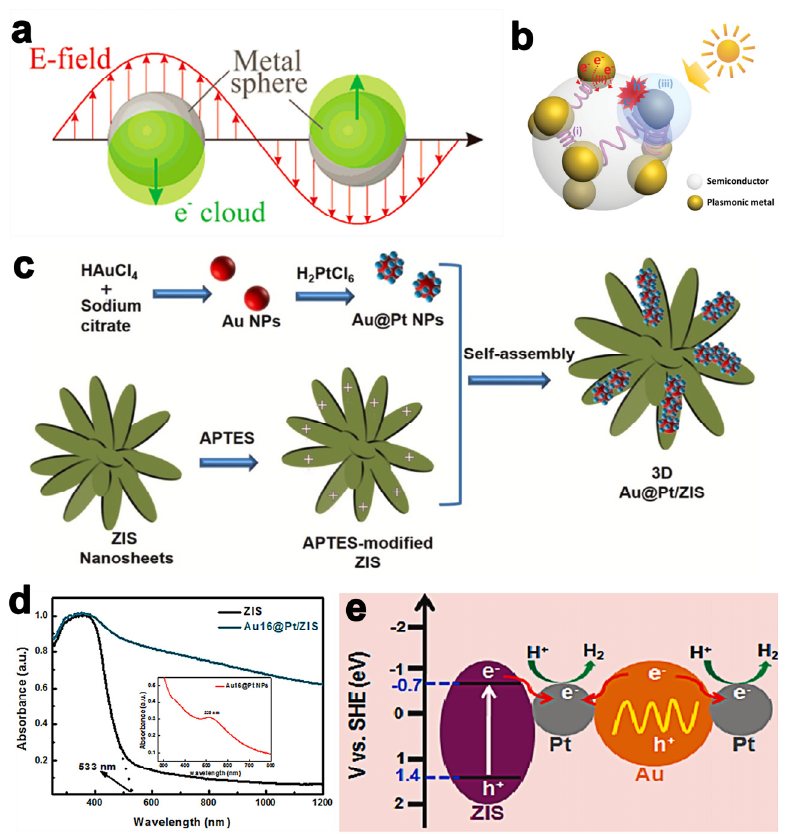
Figure 6. ( a ) Schematic illustration of plasmon oscillation on a plasmonic metal sphere [71]. ( b ) Mechanisms for photonic promotion in plasmonic nanoparticles − semiconductor heterostructures, including light scattering and concentration (i), direct electron injection energy transfer (DET) (ii), and plasmon − induced energy transfer (PIRET) (iii). Reprinted with permission from Ref. [71]. Copyright